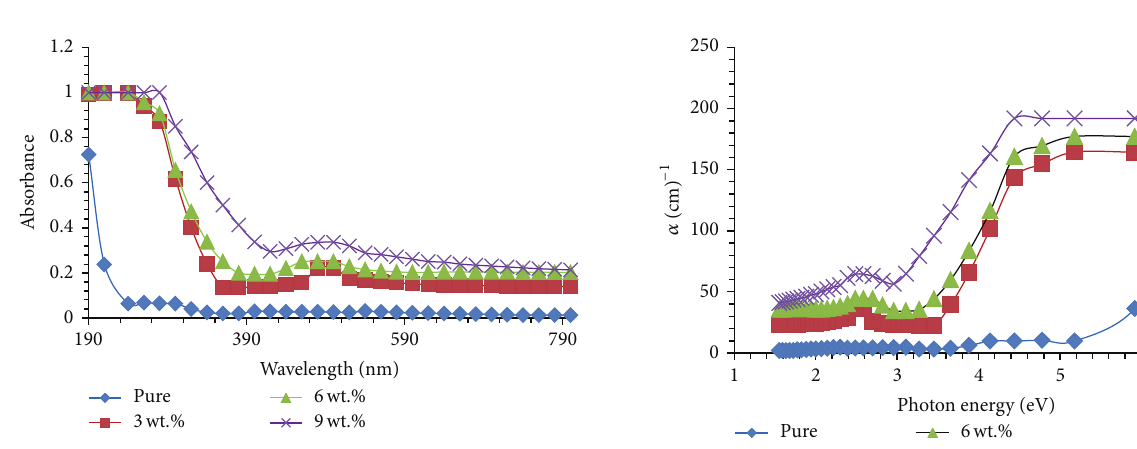
Figure 6: Optical absorption as a function of wavelength for PVAc with 0, 3, 6, and 9 wt.% concentration of [Co(NH 3 ) 5 Cl]Cl 2 at room temperature.